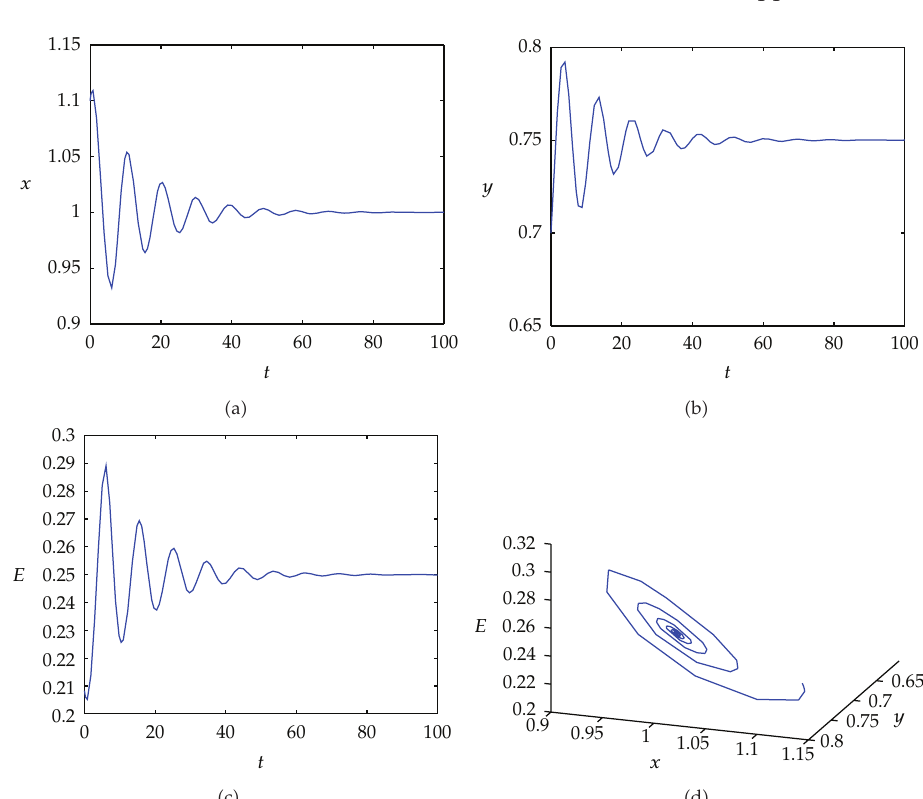
Figure 1: When τ (cid:5) 0 . 1, the positive equilibrium point Y 0 is asymptotically